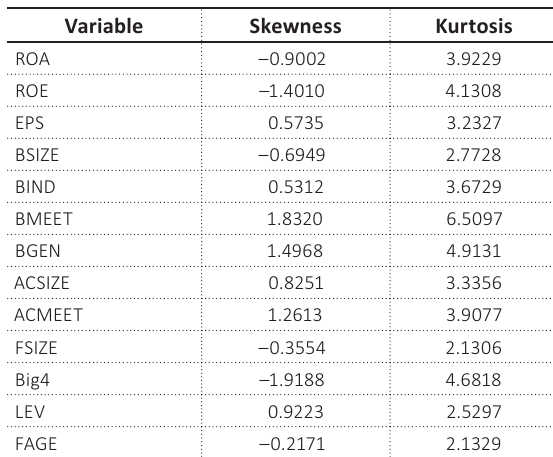
Table 5. Descriptive statistics of